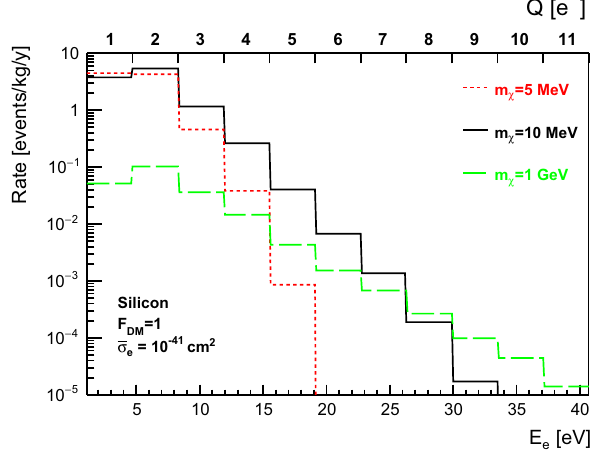
Fig. 2 Structure of a basic DEPFET